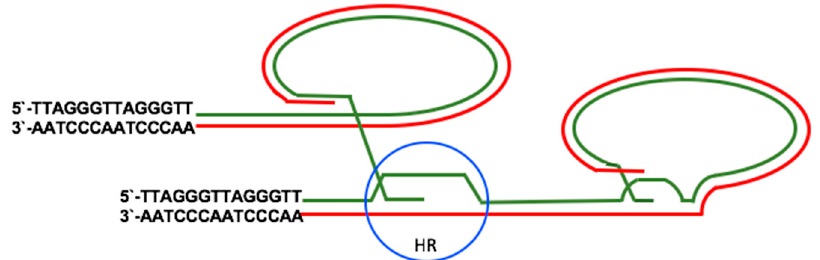
Figure 3. Schematic illustration of ALT-mediated telomere elongation. In ALT, Holliday-junctions (HJ) are formed between two sister telomeres (blue circle) or between one telomere and extra-telomeric DNA and the telomeres are elongated by homologous recombination (HR). This reaction often occurs inside promyelocytic leukemia nuclear bodies (PML-NBs).